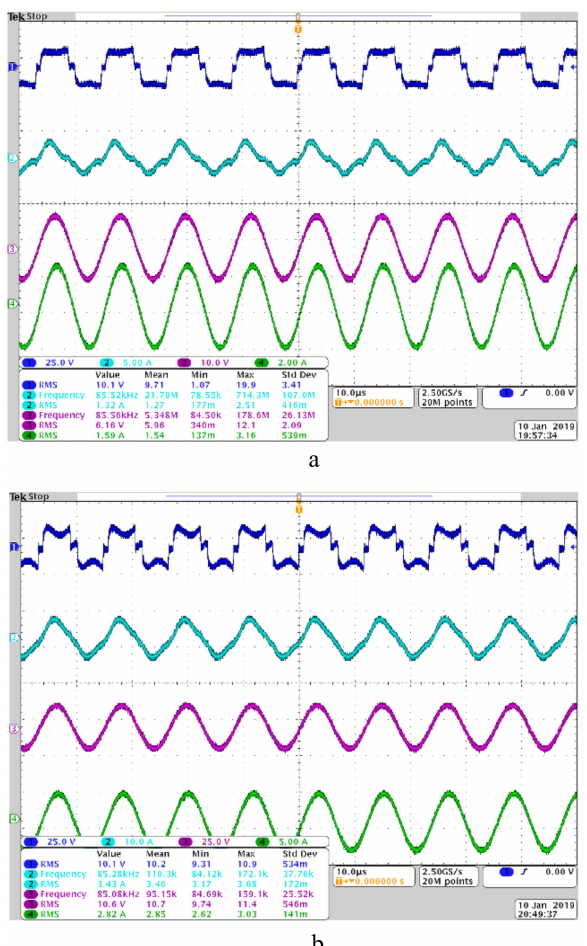
Figure 13. The experimental waveforms of different energizing modes when the receiving coil is at the middle position between two adjacent transmitting coils. ( a ) Single energizing mode. CH1 (25 V/div): output voltage of the inverter; CH2 (5 A/div): output current of the inverter; CH3 (10 V/div): voltage of the load; CH4 (2 A/div): current of the load. ( b ) Double energizing mode. CH1 (25 V/div): output voltage of the inverter; CH2 (10 A/div): output current of the inverter; CH3 (25 V/div): voltage of the load; CH4 (5 A/div): current of the load.